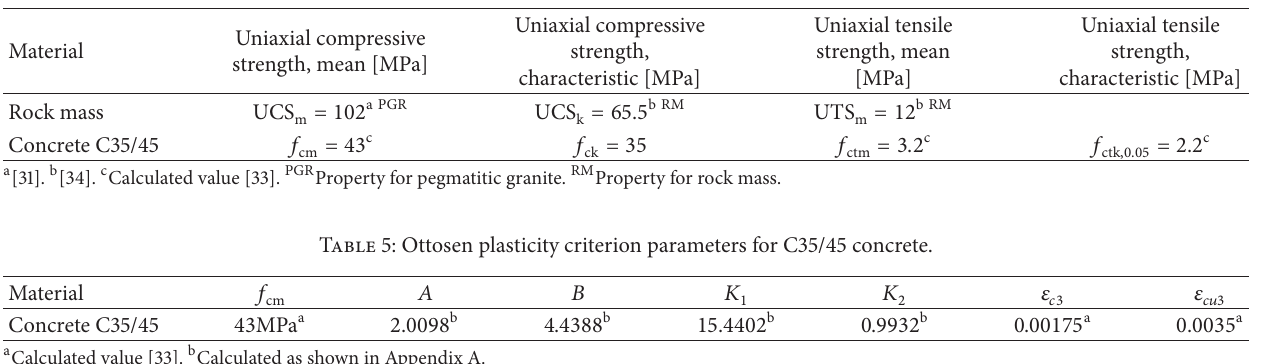
Table 4: Material strengths based on measured values and material properties.